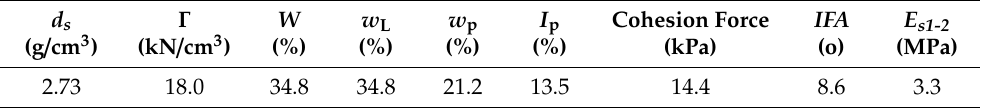
Table 1. Physical and mechanical parameters of clay soil